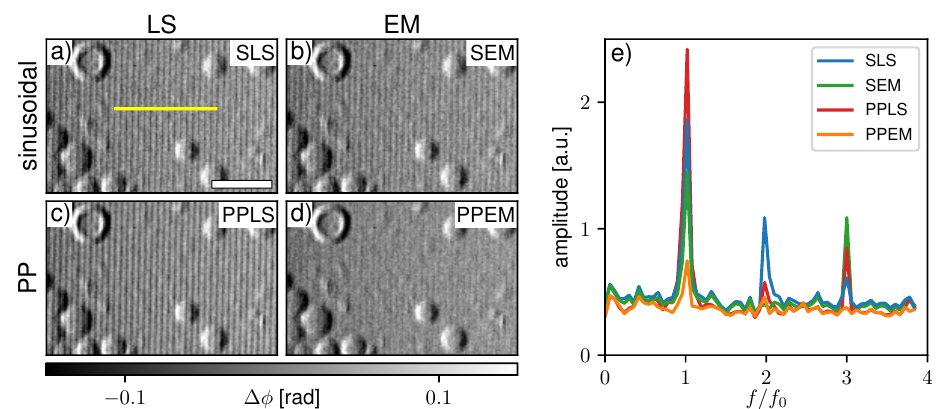
Figure 8. Differential-phase contrast images processed by ( a ) sinusoidal least square (SLS), ( b ) sinusoidal expectation maximization (SEM), ( c ) periodic polynomial least square (PPLS), and ( d ) periodic polynomial expectation maximization (PPEM) from a single grating X-ray interferometer. ( e ) Fourier spectra for the respective processing schemes averaged from 50 pixel rows next to the yellow line in ( a ). The white scale bar in ( a ) represents 50µm.